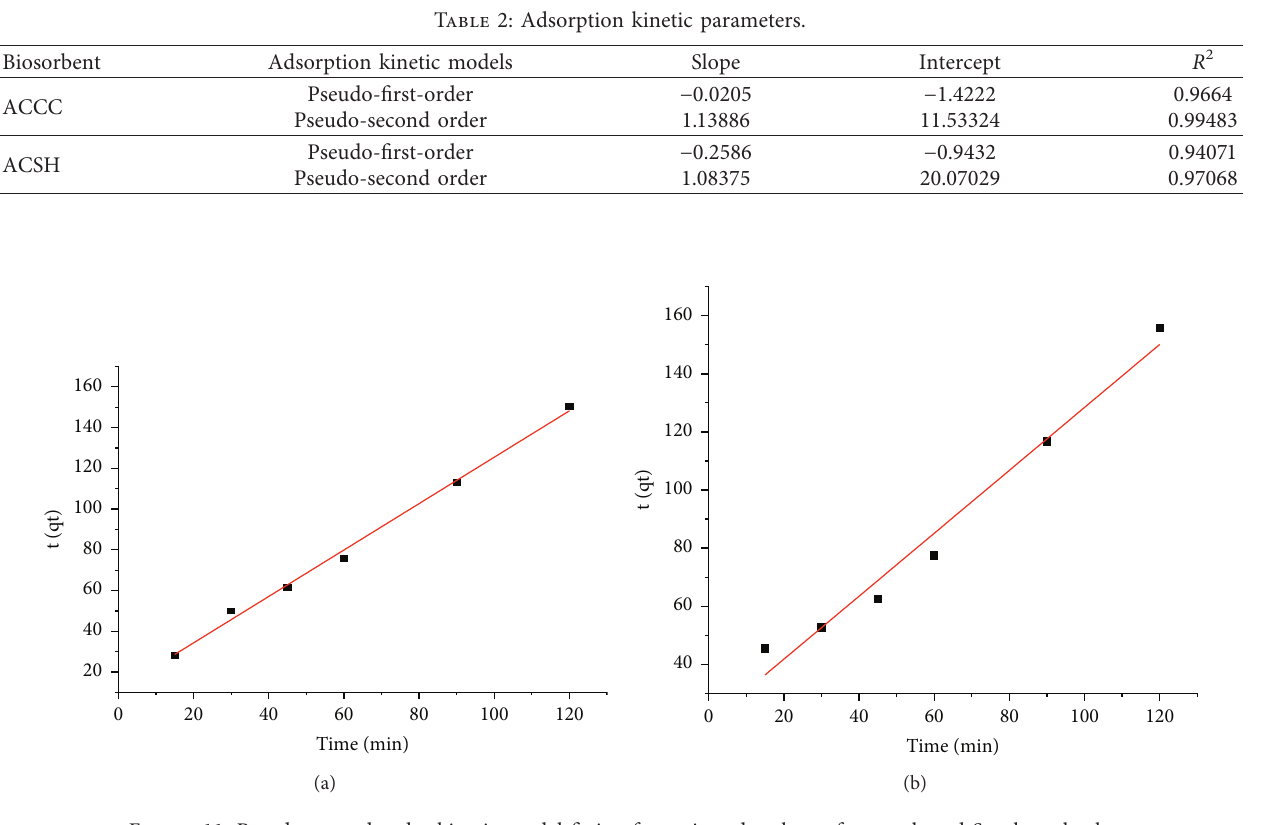
Figure 11: Pseudo-second order kinetic model fitting for activated carbon of corncob and Sorghum husk.